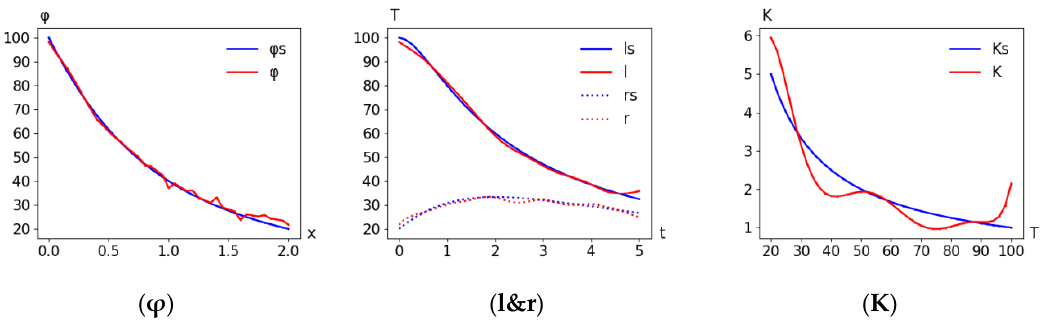
Figure 4. SvF solution of Problem 5.1: ( T ) contour lines of T(x,t) ; ( T6 ) 6 slices of T(x,t) ; ( Err ) Err(x,t) = T(x,t)-Ts(x,t) ; ( φ ) the initial condition; ( l&r ) boundary conditions; ( K ) the thermal conductivity coefficient K(t) .